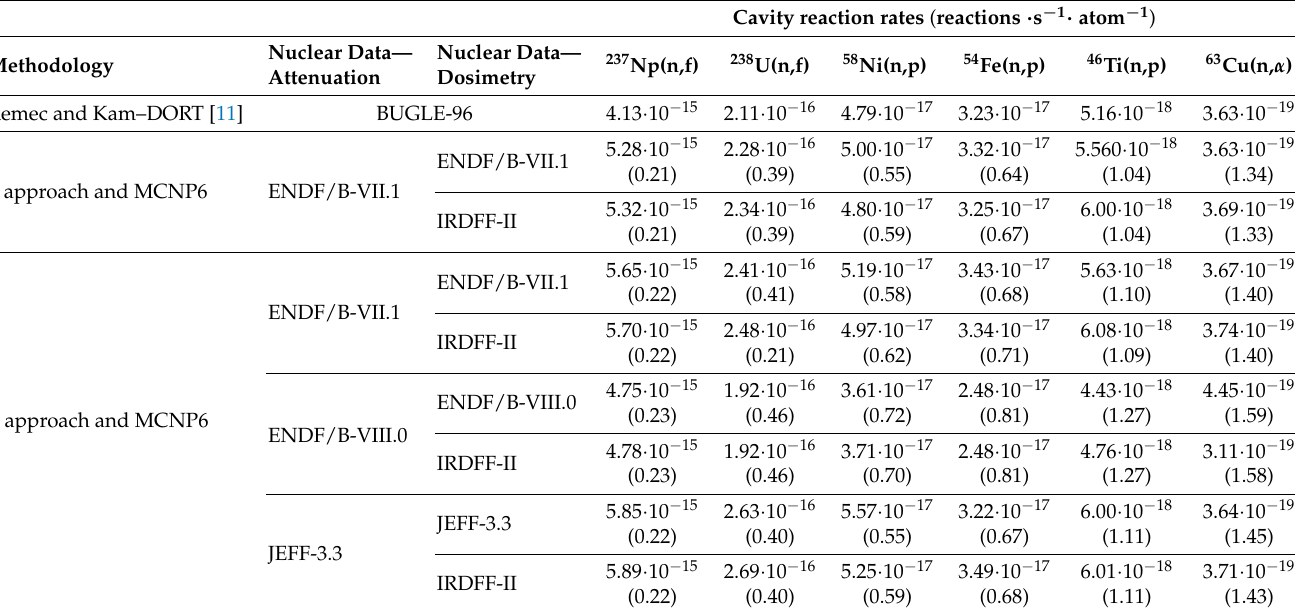
Table 6. Reaction rates obtained in the reactor cavity. Values in parentheses indicate the standard deviations of MCNP6 tally responses (in units of